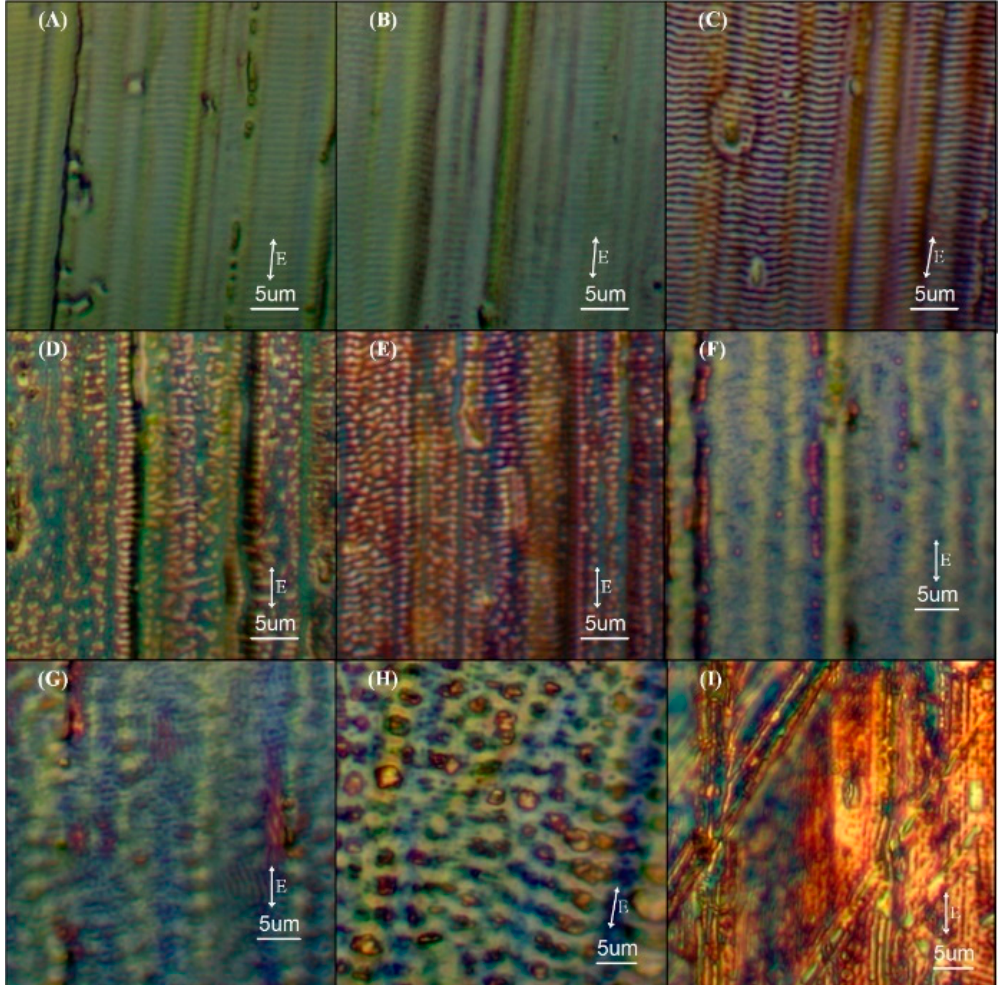
Figure 5. Surface morphology of samples ( ϕ = 0.955 J / cm 2 ). ( A ) N = 25, the spot centre; ( B ) N = 50, the spot centre; ( C ) N = 75, the spot centre; ( D ) N = 100, the spot centre; ( E ) N = 100, facula edge; ( F ) N = 125, the spot centre; ( G ) N = 125, facula edge; ( H ) N = 150, the spot centre; ( I ) N = 150, facula edge.